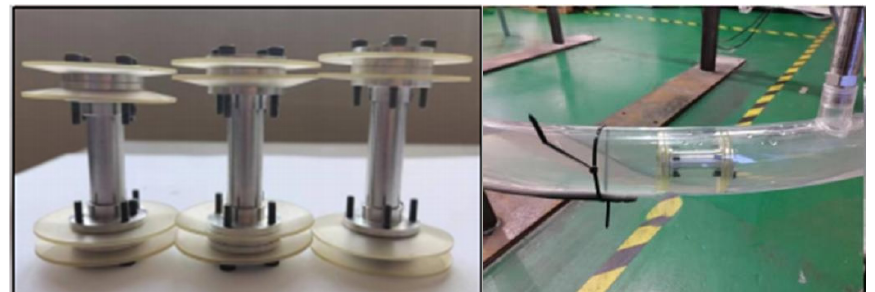
Figure24 . Pipeline robot with two − cup, four − cup and six − cup. Figure 24. Pipeline robot with two-cup, four-cup and six-cup.